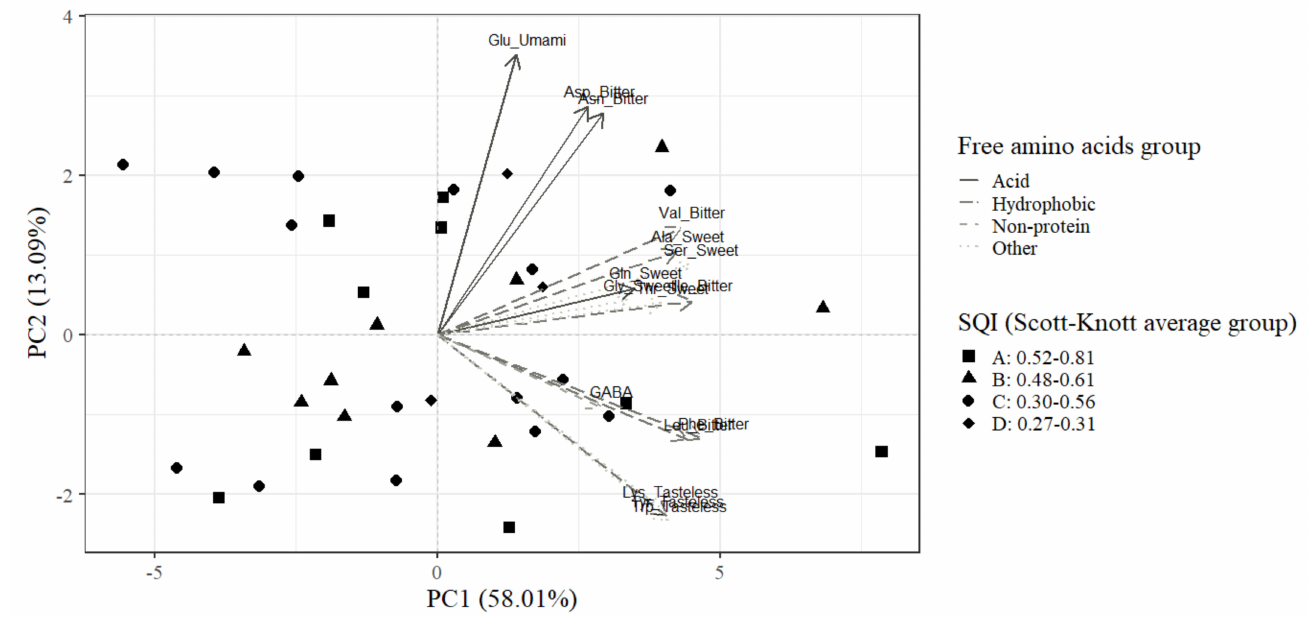
Figure 3. Biplot of principal component analysis (PCA) applied to the free amino acids of PH-16 dry cacao beans correlated with samples represented by Scott-Knott average groups (decreasing order A, B, C and D) for the Soil Quality Index (SQI): asparagine (Asn), aspartic acid (Asp), glutamine (Gln), glutamic acid (Glu), alanine (Ala), isoleucine (Ile), leucine (Leu), phenylalanine (Phe), tyrosine (Tyr), valine (Val), gamma-aminobutyric acid (GABA), glycine (Gly), lysine (Lys), serine (Ser), threonine (Thr), tryptophan (Trp). Taste classification: bitter, sweet, tasteless, umami. Thirty-six sample